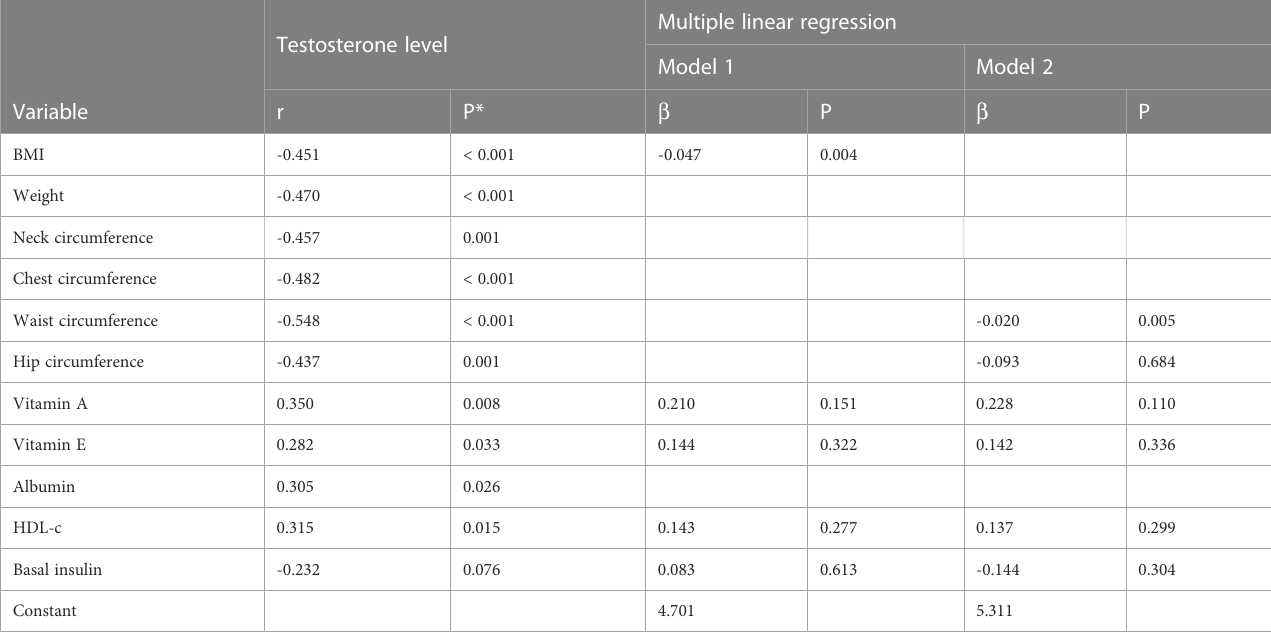
TABLE 3 Correlation between preoperative testosterone level and anthropometric and clinical variables (n =